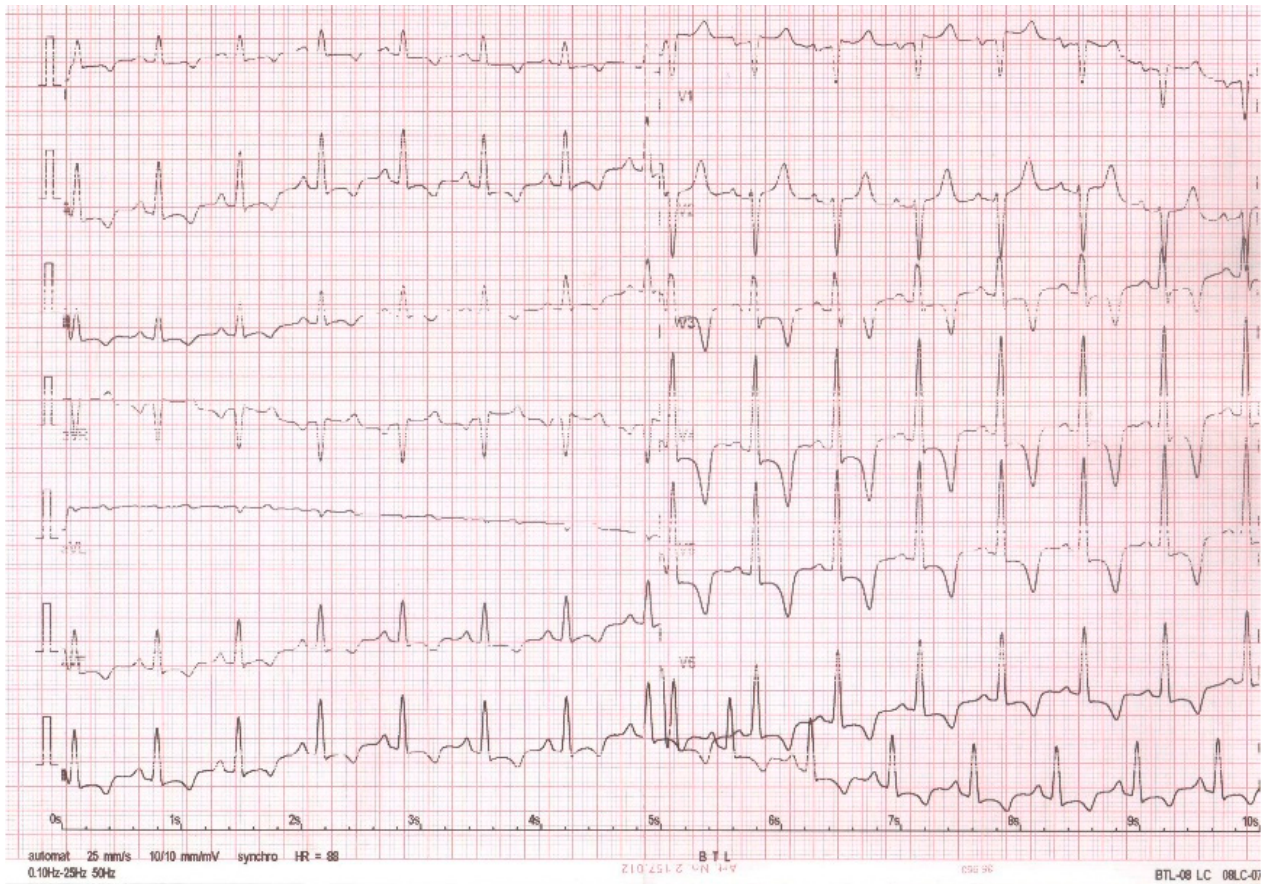
Figure 1. Twelve-lead electrocardiogram—sinus rhythm and deep inverted T waves in most leads (excepting V1, V2, and aVR), and a corrected QT interval of 533 msec. Cardiac magnetic resonance imaging was further performed. Native and post-contrast (9 mmol gadolinium) images were acquired. bSSFP Cine imaging showed a non-dilated left ventricle with preserved ejection fraction and apical obliteration (Figure 2C and Sup- plementary Videos S1 and S2). Inversion recovery images 10 min after contrast injection showed sub-endocardial late gadolinium enhancement (LGE) pointing toward the apex and left ventricular apical non-enhancing mass-thrombus (Figure 2D)”.